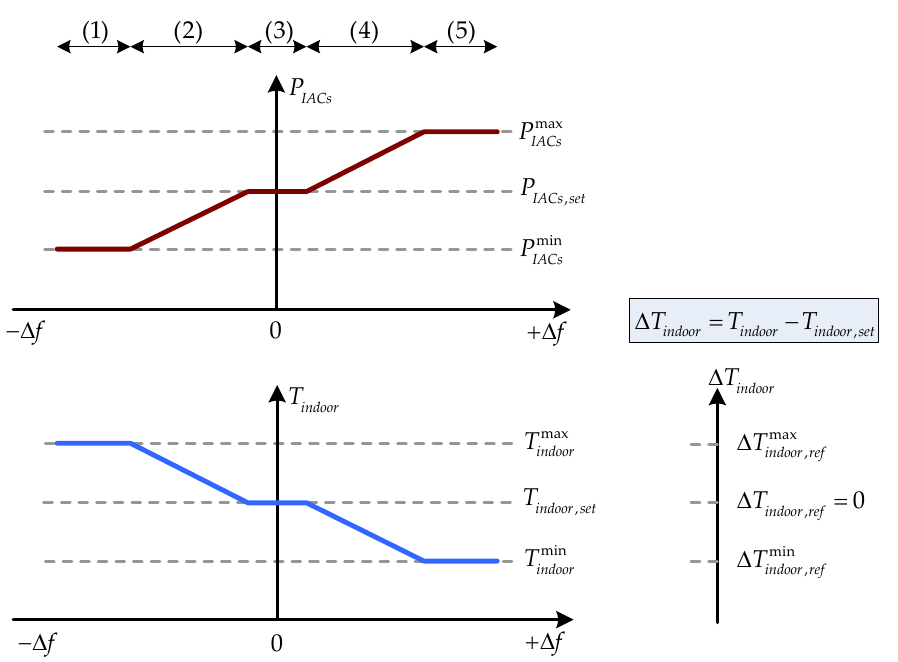
Figure 4. IACs power control and indoor temperature against frequency deviation.